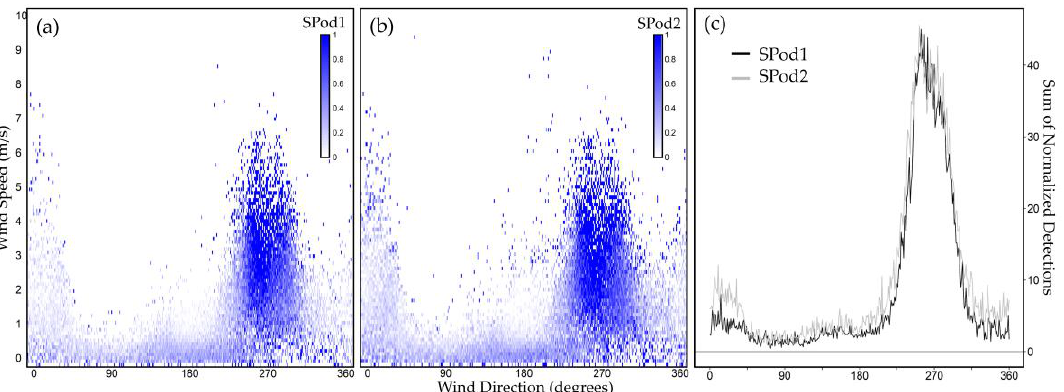
Figure 7. Wind direction and wind speed-resolved frequency of detection plots for ( a ) SPod1; ( b ) SPod2; ( c ) showing the cumulative detection probability for both SPods by wind direction.